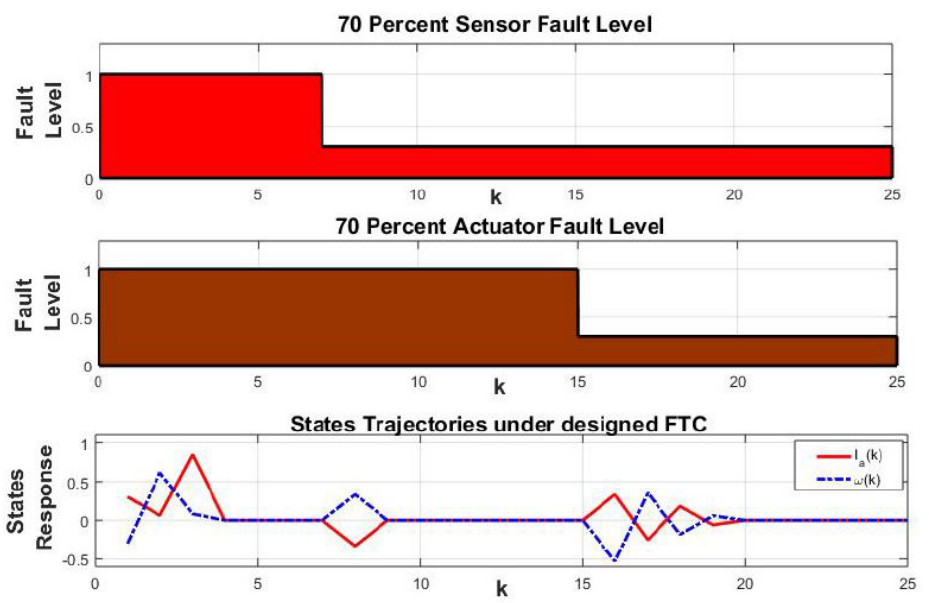
Figure 7. Case 2: Multiple (sensor and actuator) types of simultaneous faults. Fault level is 70